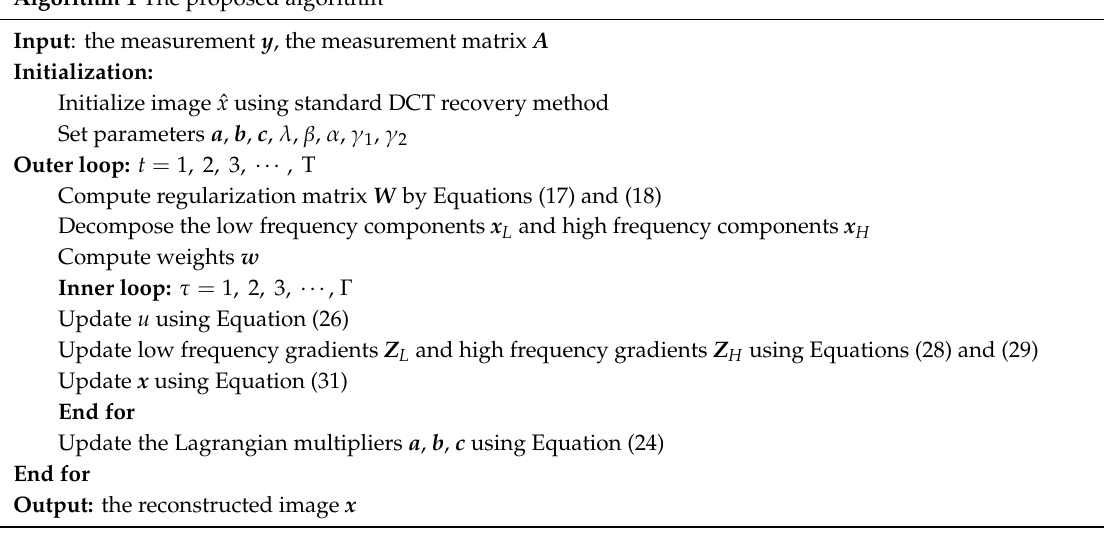
Algorithm 1 The proposed